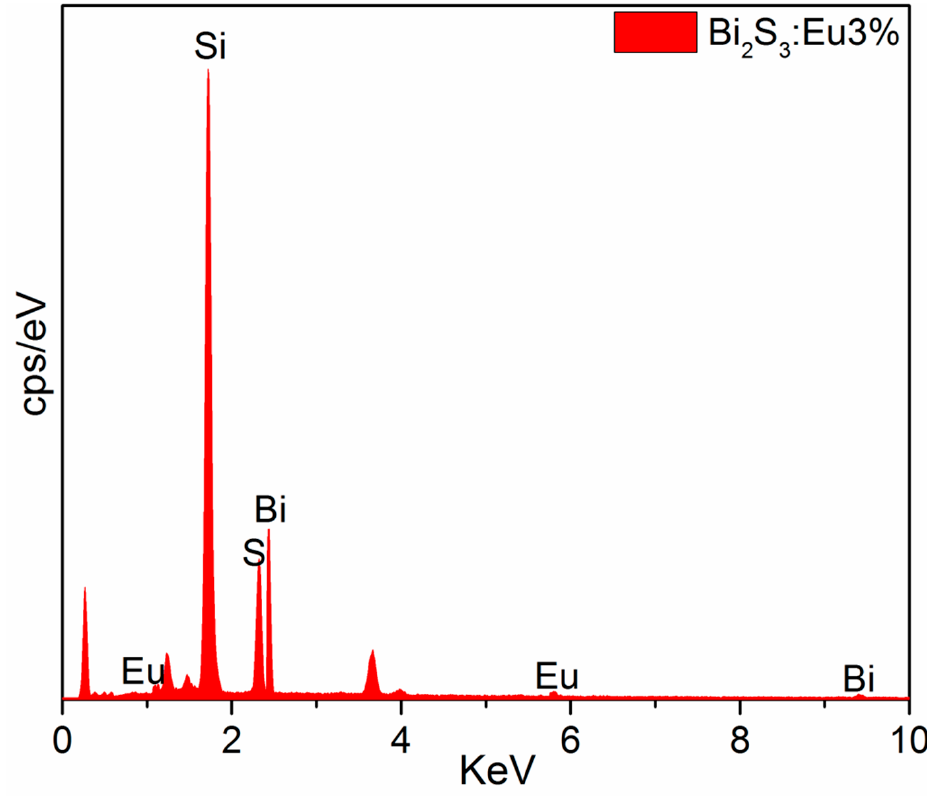
Figure 3. EDX spectrum of 3% Eu-doped Bi 2 S 3 thin film.